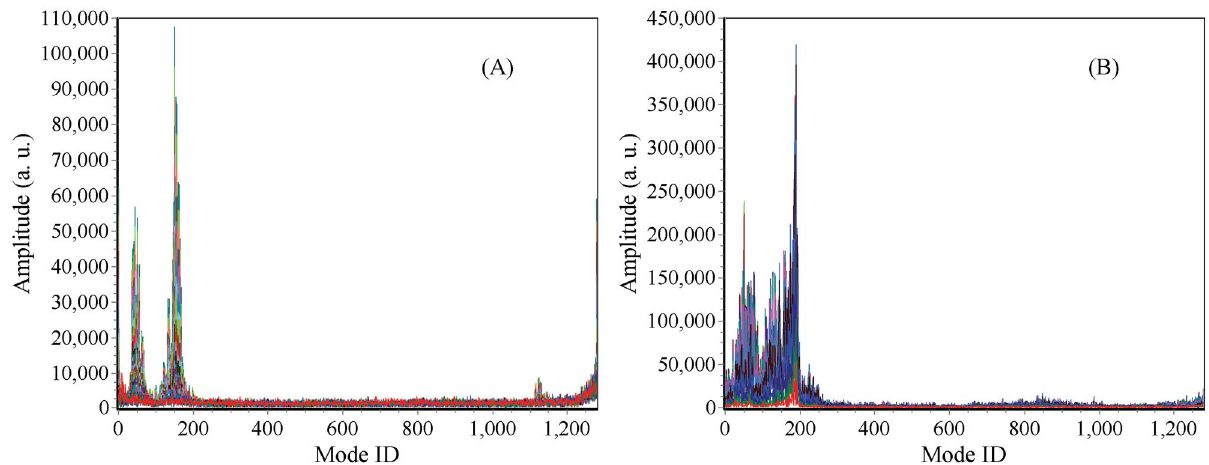
].FIG. 12. (Color) Unstable modes with 40% of the solenoid magnets turned off for the horizontal plane (a) and the vertical plane (b) (cid:1) 100% , L (cid:1) 60% ]. [ B sol sol